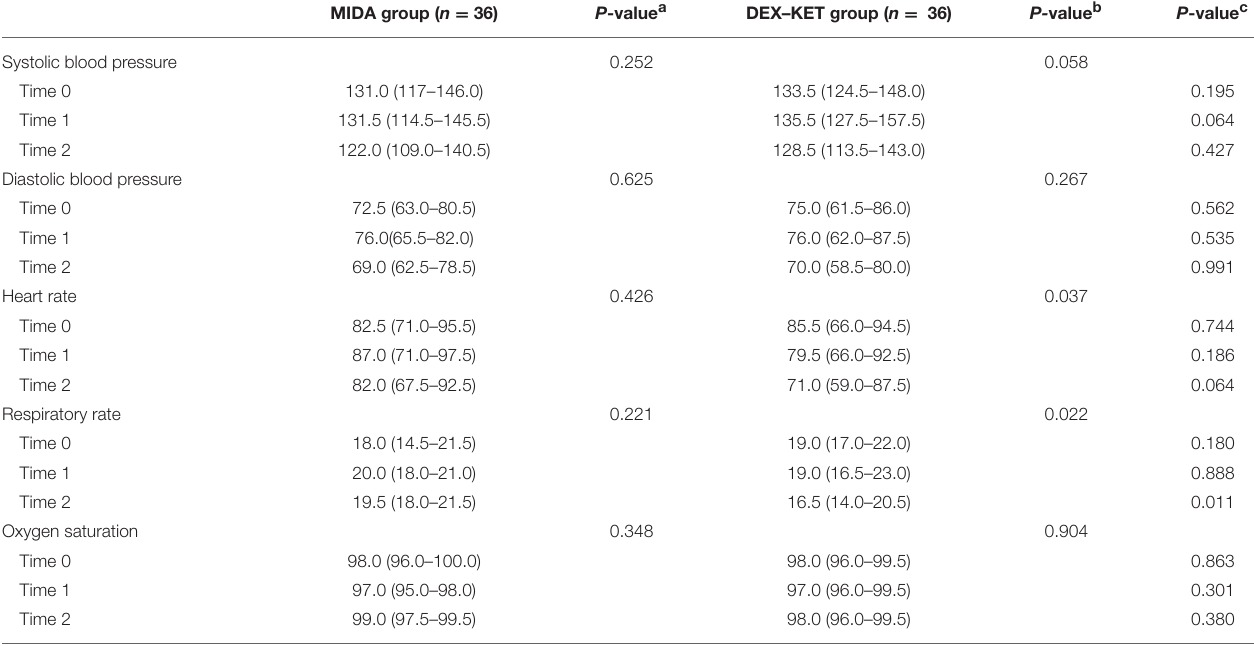
TABLE 2 | Sedation-related changes in vital signs.